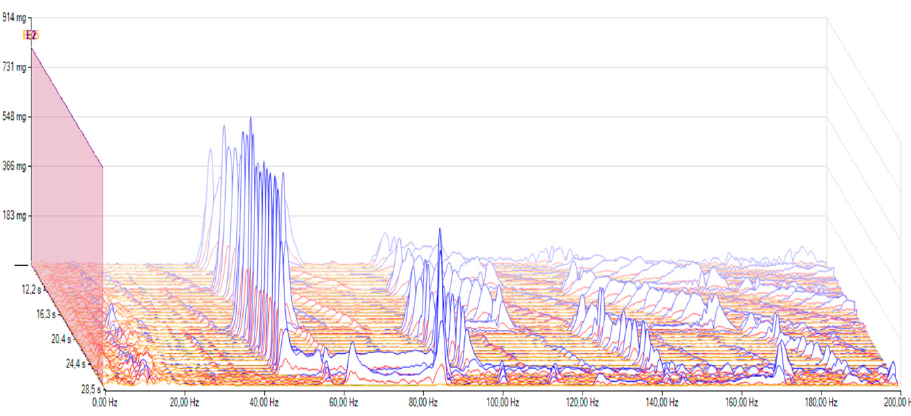
Figure 12. Vibrations in the frequency domain after the oil change, 0–70 km/h.